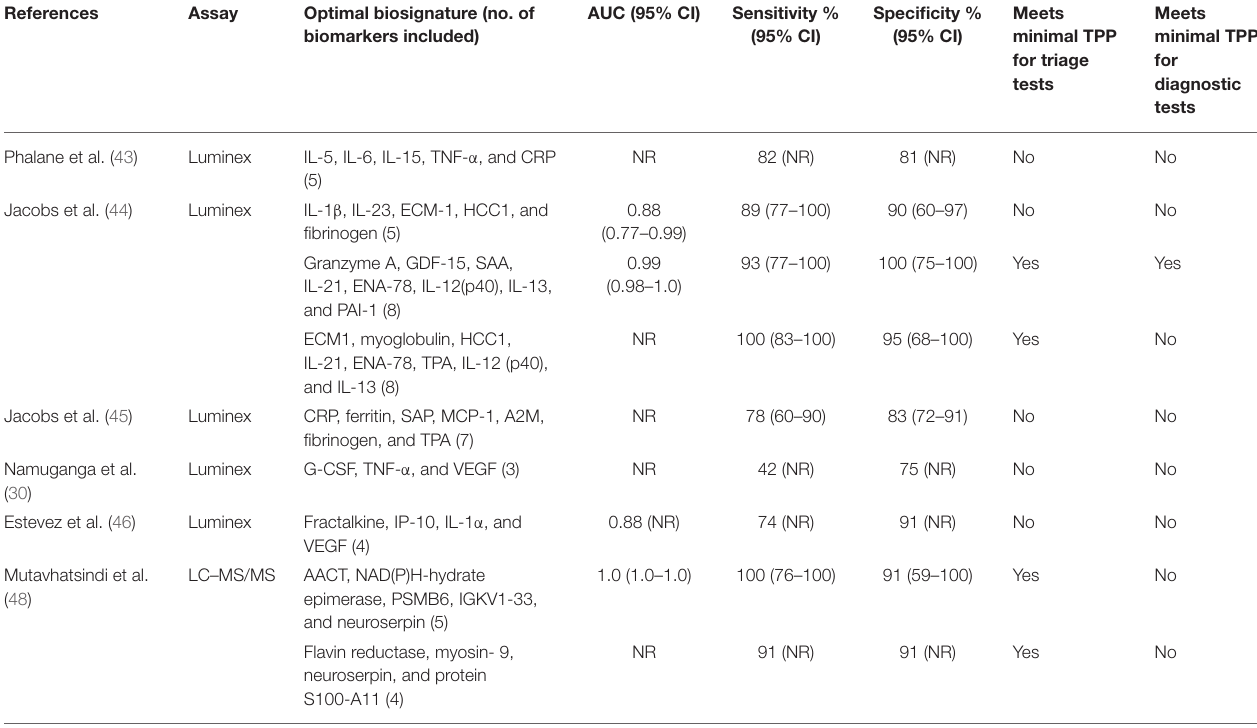
TABLE 2 | Optimal biosignatures in relation to WHO-endorsed target product profiles for triage tests (90% sensitivity and 70% specificity) and diagnostic tests (66% sensitivity and 98%